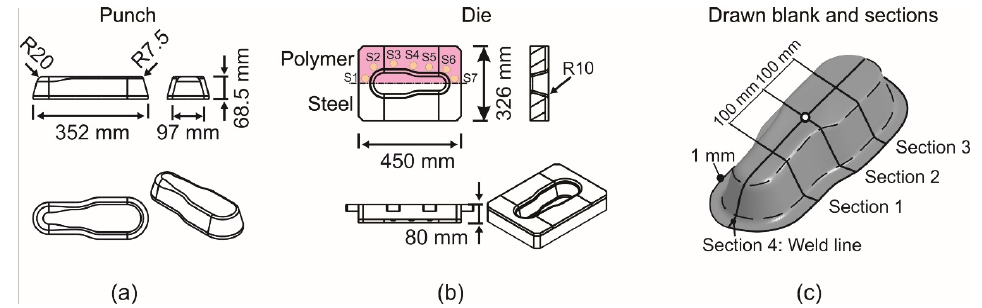
Figure 3. Dimensions of tool for complex geometry in mm. ( a ) Punch; ( b ) die; ( c ) drawn sheet and sections.